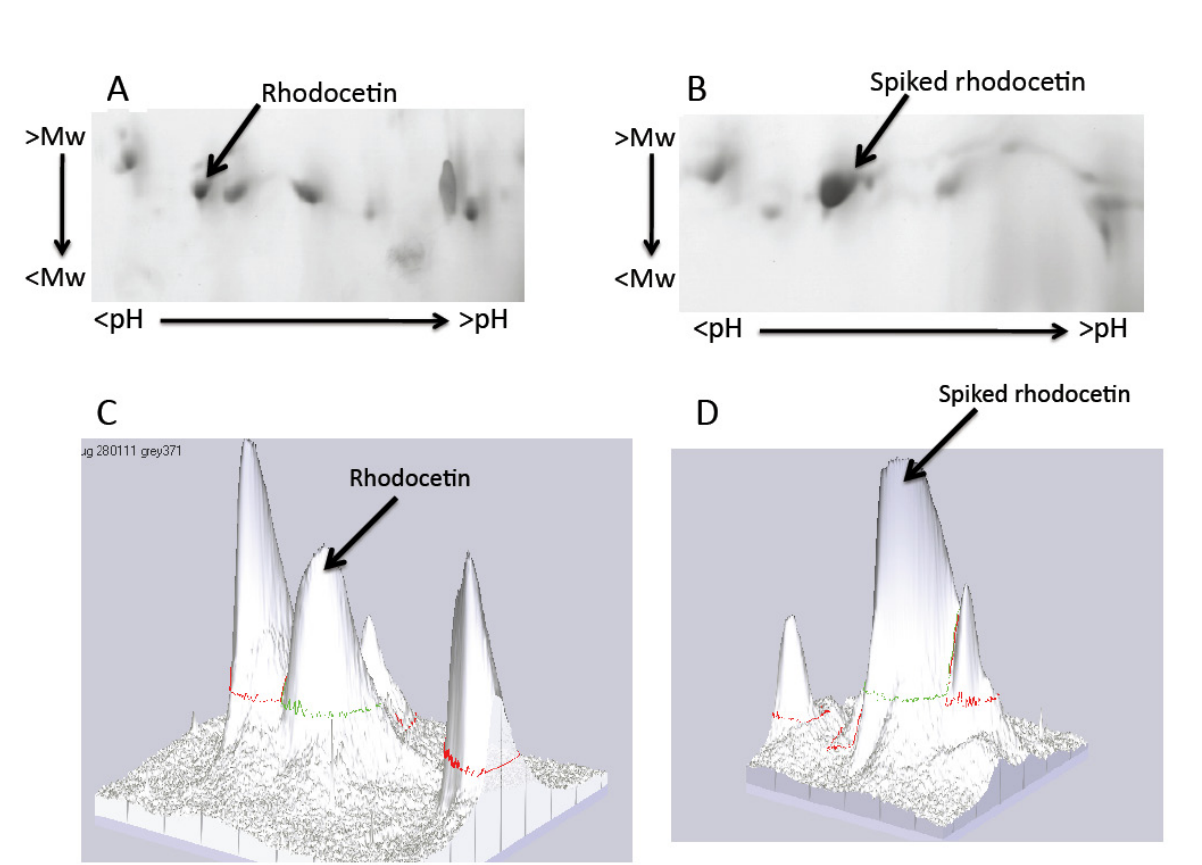
Figure 4. ( A ) Area of interest on the 2DE profile of crude CR venom with the rhodocetin (α subunit) spot labeled. ( B ) The same area showing the spot of spiked rhodocetin with an observed increased intensity. ( C ) Three dimension representation of the rhodocetin (α subunit) spot on the crude venom alone and ( D ) of the spiked rhodocetin (α subunit) spot, the latter having a quantified 1.6 fold increase in